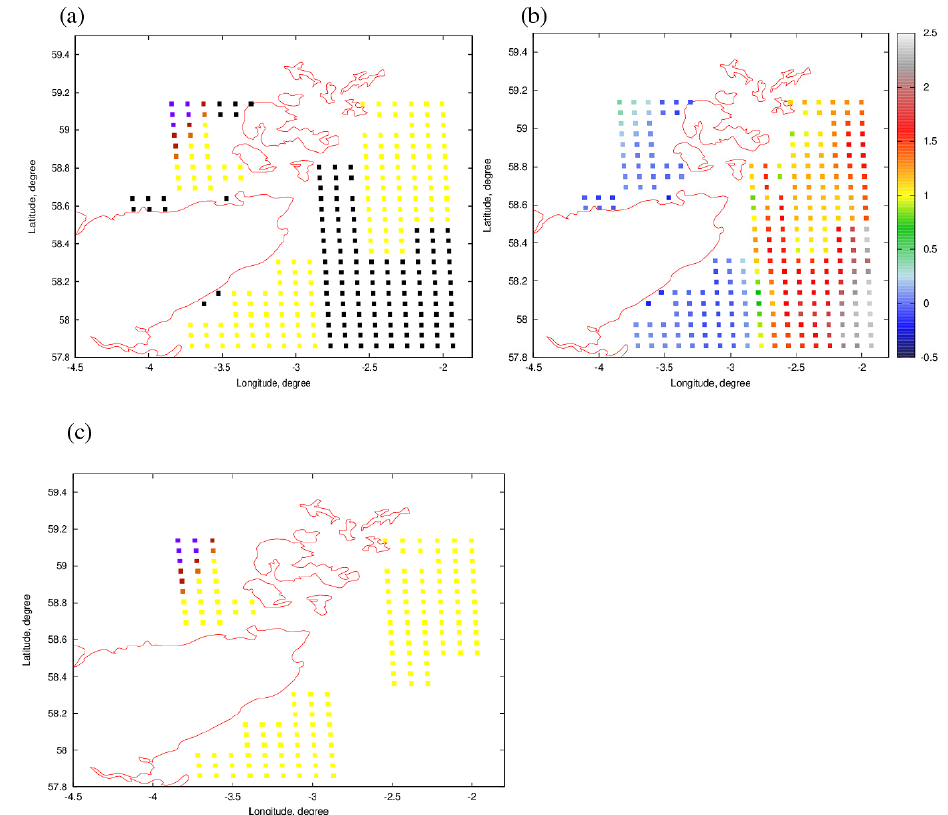
Figure 9. The PARASOL estimates of ensemble model randomisations (based on minimised RMSE) and retrievals of optical thickness as a function of latitude and longitude. (a) The estimated ice crystal randomisation, where the indeterminate results are shown by the black squares, the most randomised phase functions (distortion = 0.4 with spherical air bubble inclusions) by the yellow squares, and the pristine phase functions (distortion = 0) by the purple squares; dark- and light-brown squares represent the slightly distorted (distortion = 0.15) and moderately distorted (distortion = 0.25) phase functions, respectively. (b) The PARASOL-retrieved averaged optical thickness, averaged over all scattering angles, where the decadal logarithm of the retrieved optical thickness is shown by the colour bar on the right-hand side of the figure. (c) The same as (a) but with the indeterminate results